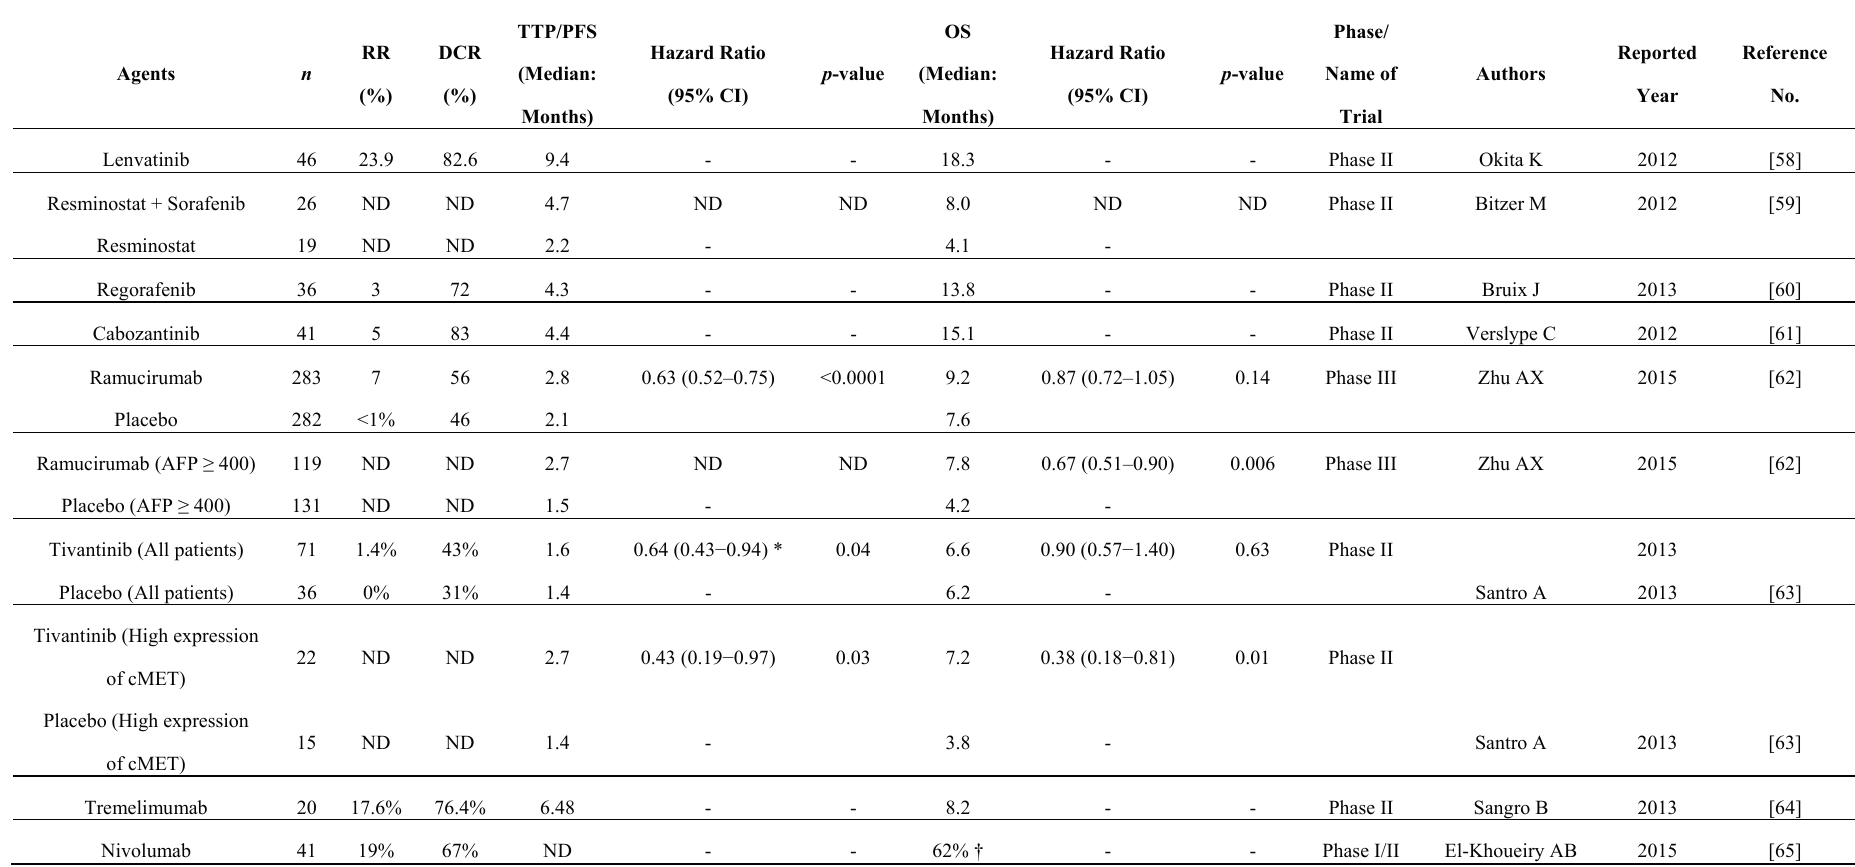
Table 3. Results of main clinical trials of promising agents in patients with advanced HCC: Post